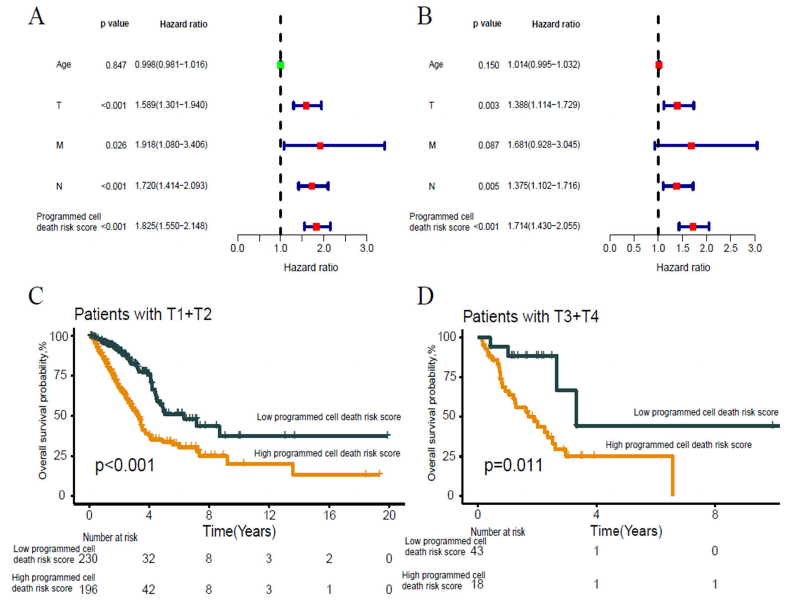
Figure 7. Analysis of independent prognostic factors in lung adenocarcinoma. ( A ) Univariate cox regression analyses for the clinical characteristics. ( B ) Multivariate cox regression analyses for the clinical characteristics. ( C ) KM survival curve of programmed cell death risk score in patients with T1 or T2. ( D ) KM survival curve of programmed cell death risk score in patients with T3 or T4.